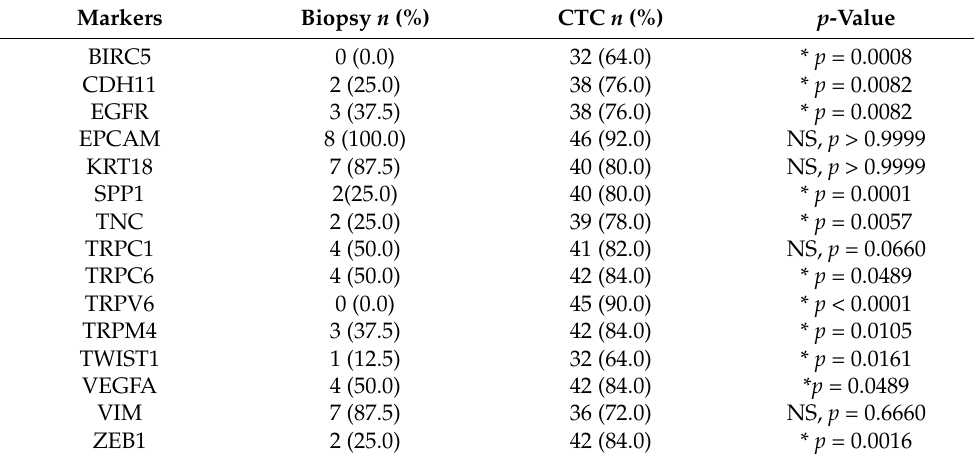
Table 2. The analysis by the Fisher’s exact test of the marker expression in the CTCs with respect to the